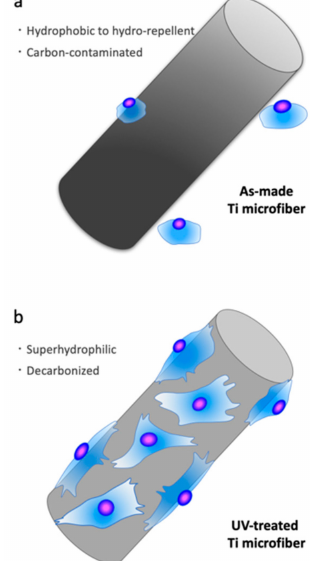
Figure 9. Schematic description of osteoblast behavior on Ti microfibers. ( a ) Ti microfibers are thin, rounded, hydrophobic / hydrorepellent, and inadvertently covered by hydrocarbon molecules, on which osteoblasts show extreme di ffi culty in attaching and setting. ( b ). In contrast, UV treatment converts the Ti microfiber surface to superhydrophilic and significantly removes hydrocarbons, which allows the osteoblasts to attach to the surface and spread, leading to the manifestation of normal osteogenic function even on this thin and rounded